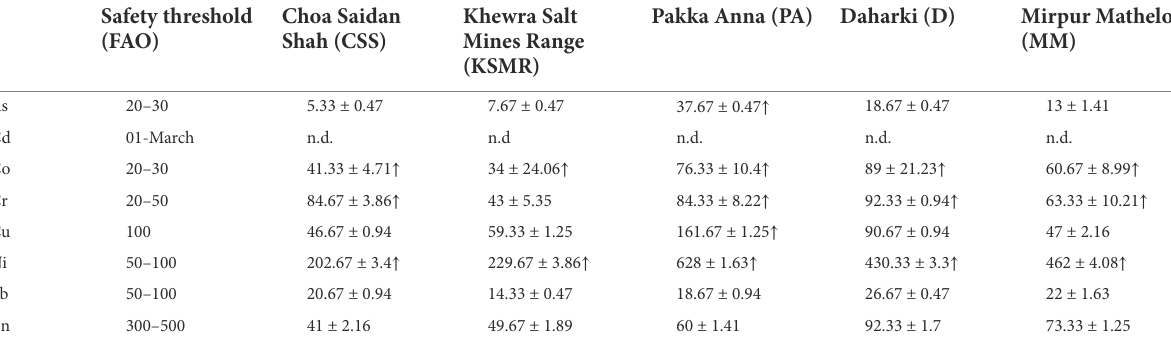
TABLE 2 Concentrations of heavy metals and metalloids in soil samples collected from five farms in the Indus Basin Region,